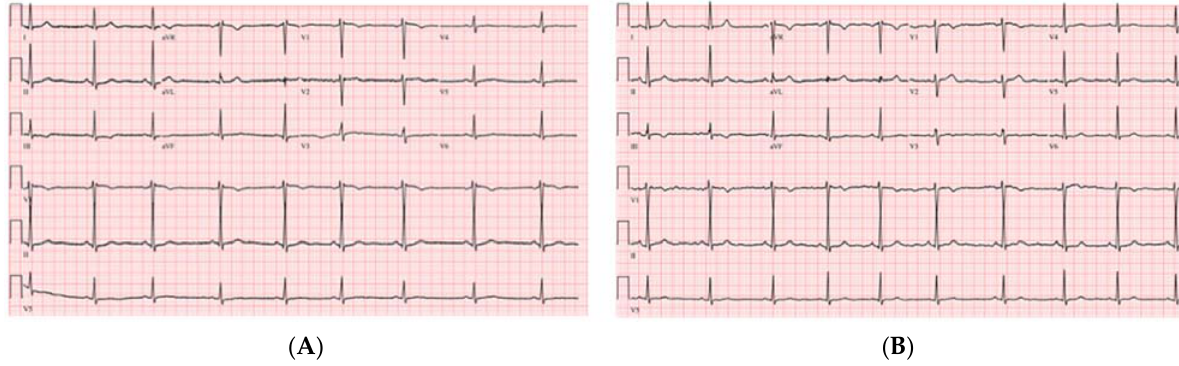
Figure 1. The ( A ) electrocardiogram sinus bradycardia at rate of 48 beats per minute, and ( B ) scheme 1 mg of atropine IV with normal sinus rhythm at rate 60 beats per minute.